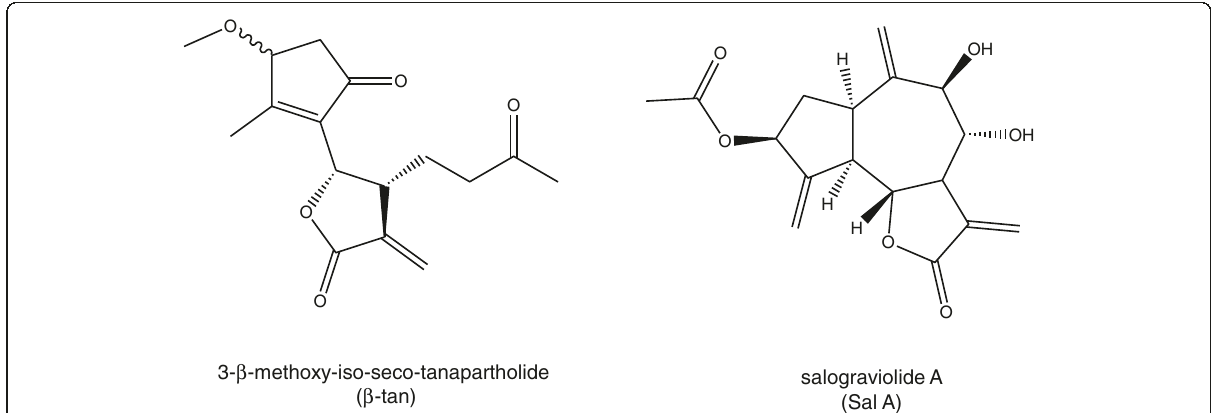
Figure 1 Chemical structures of 3- β -methoxy-iso-seco-tanapartholide ( β -tan) and salograviolide A (Sal A) from Achillea falcata and Centaurea ainetensis , respectively.